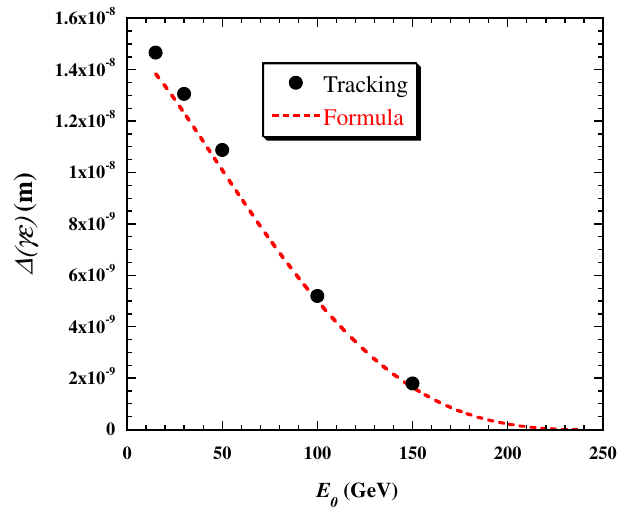
FIG. 6. Emittance growth induced by quadrupole magnet off- set 1 (cid:10) m (RMS) at the end of the linac (beam energy 250 GeV), as a function of initial beam energy. Results of tracking simu- lation (black circles) and the analytic formula (dashed line) for the ILC main linac.